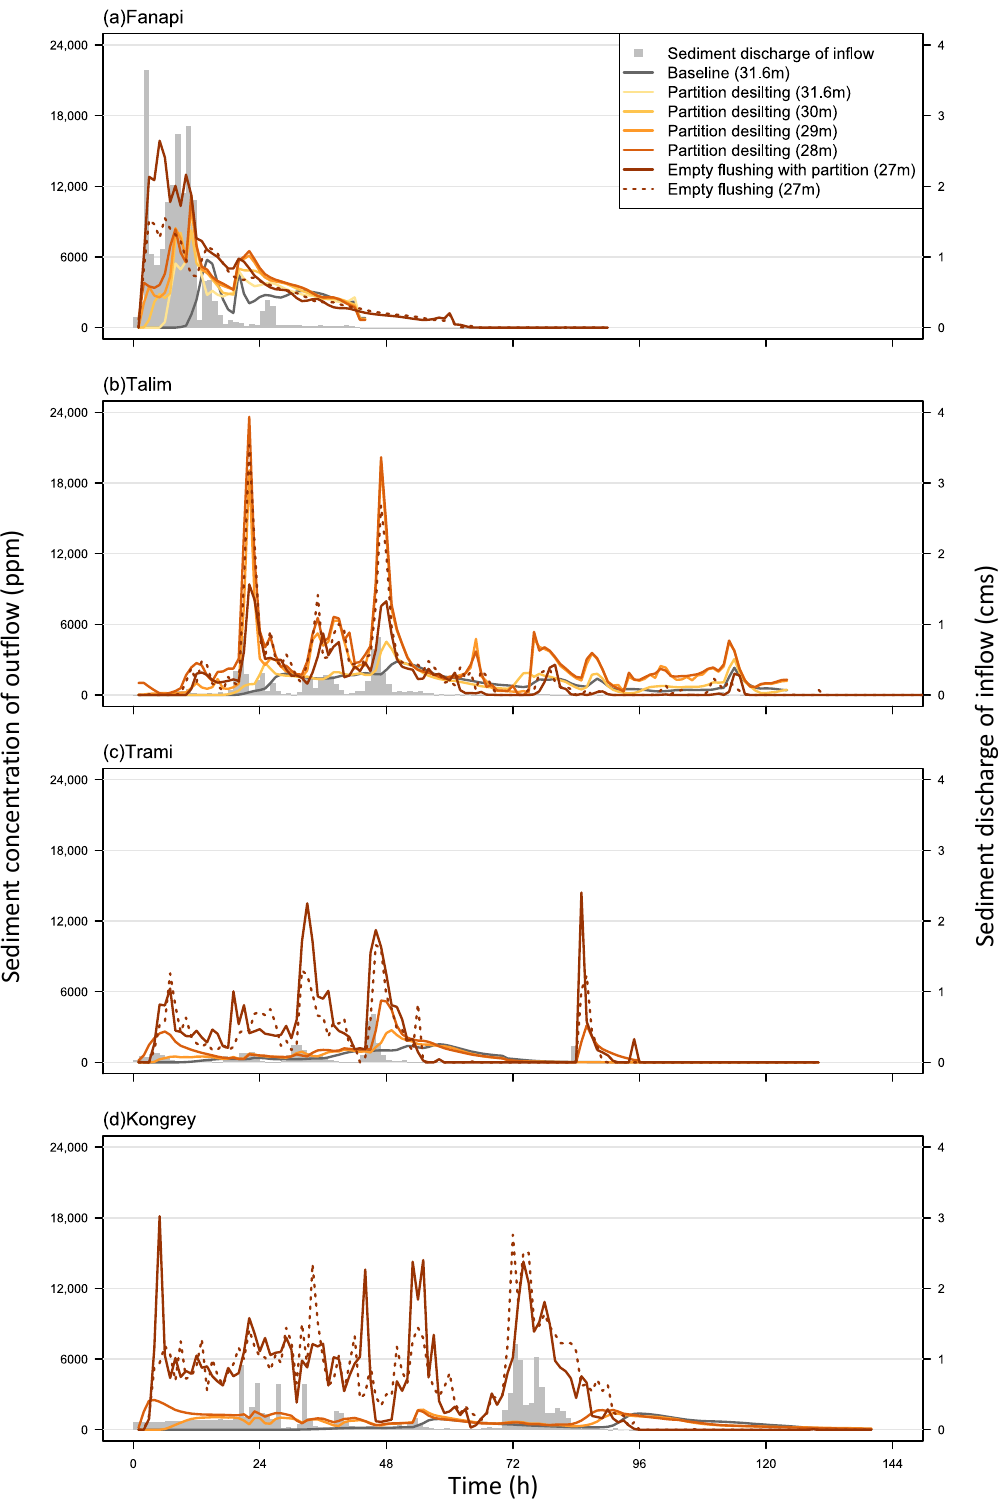
Figure 7. Di ff erent outflow sediment concentrations for each typhoon event based on the di ff erent Figure 7. Different outflow sediment concentrations for each typhoon event based on the different drawdown drawdown strategies.